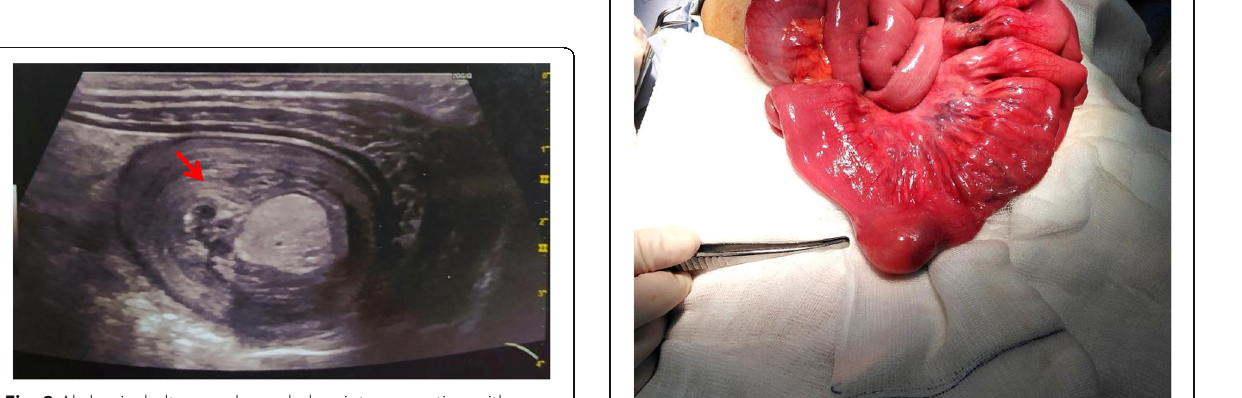
Fig. 2 Abdominal ultrasound revealed an intussusception with typical target sign (arrow)